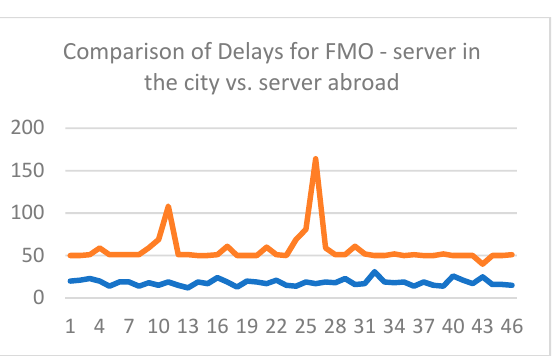
Figure A3. Comparison of DEL: MDUA.